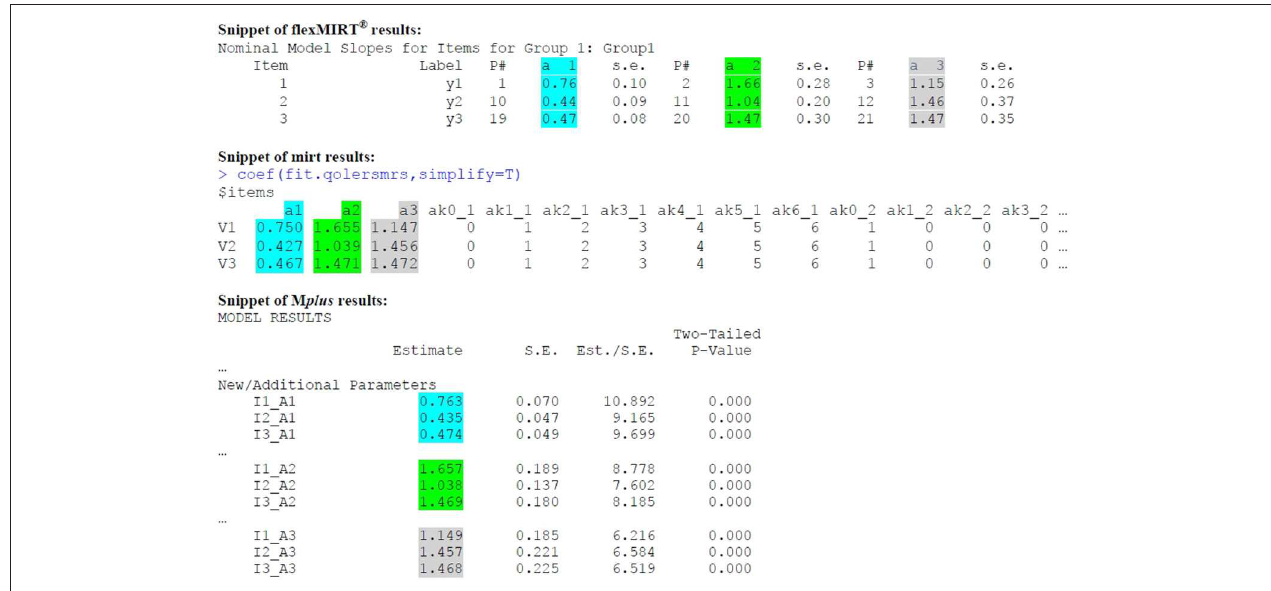
FIGURE 3 | Slope estimate output for the first three